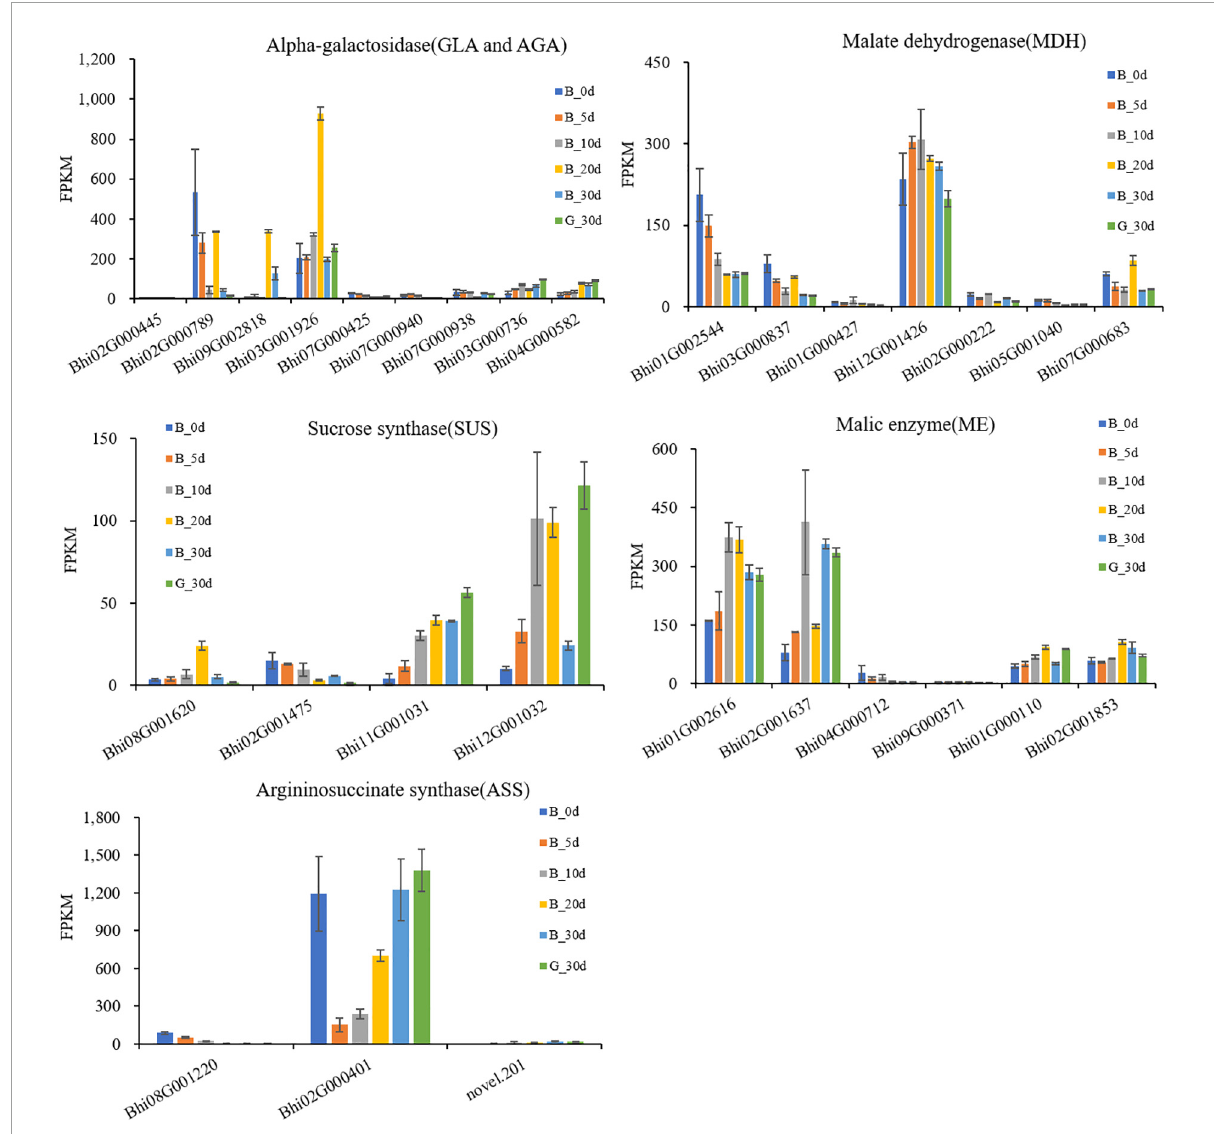
FIGURE6 RNA-Seq expression profiles of AGA/GLA, SUS, MDH, ME, ASS family genes at different developmental stages in B fruit from 0 to 30 DAP, G fruit at 30